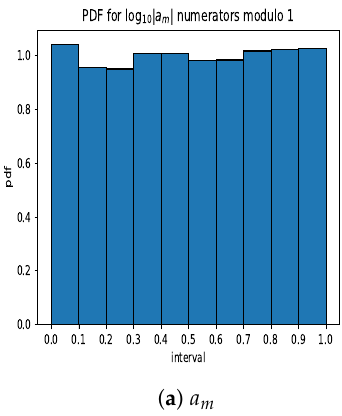
Figure 6. a m and b m